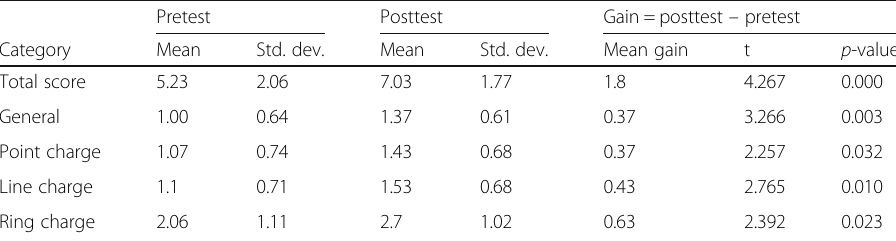
Table 3 Descriptive and inferential statistics of student conceptual